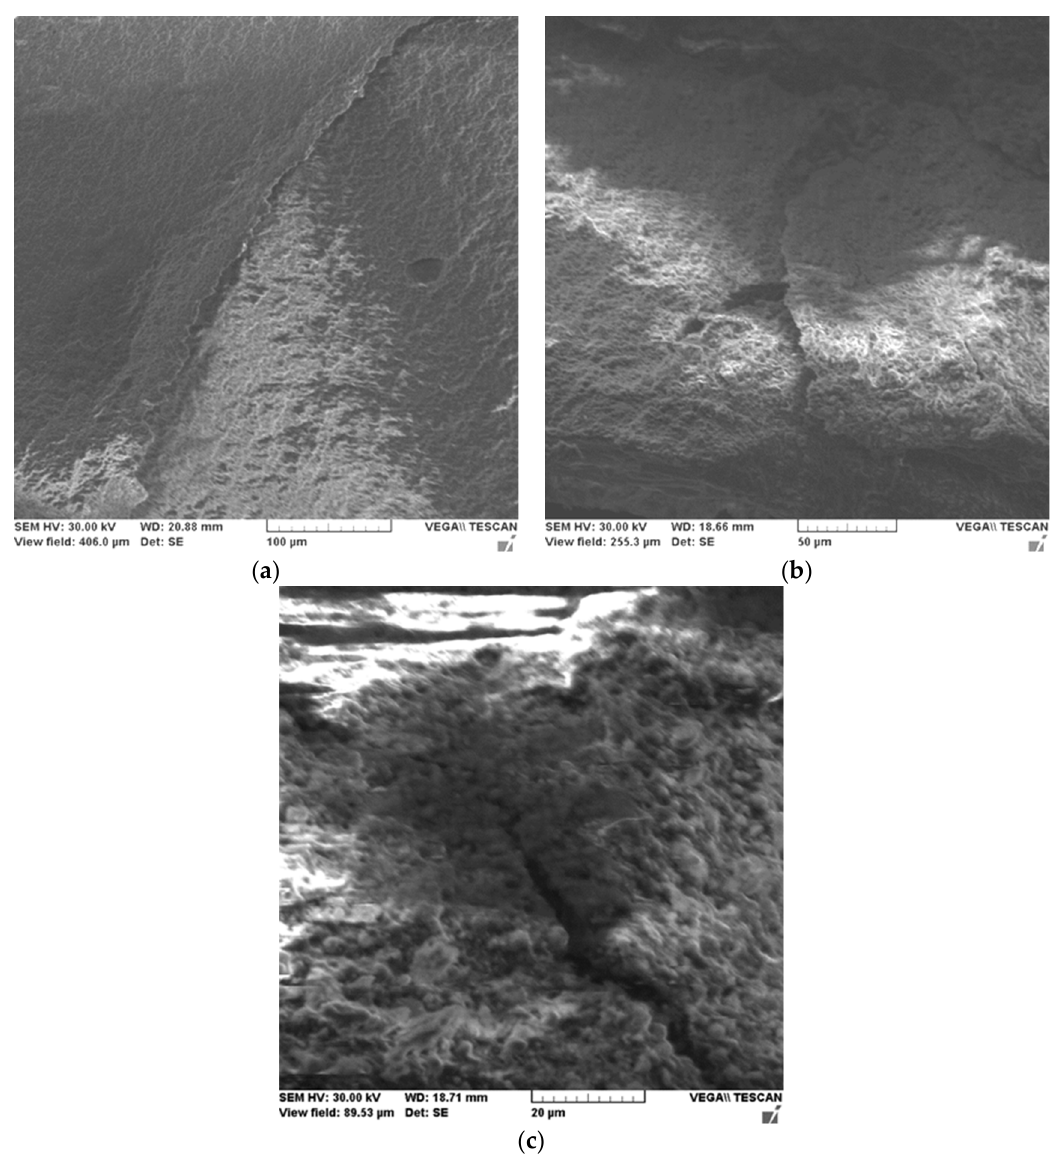
Figure 3. SEM microscopies of the Filtek Supreme XT-2 sample at various magnification powers: 700 × ( a ), 1100 × ( b ) and 3200 × ( c